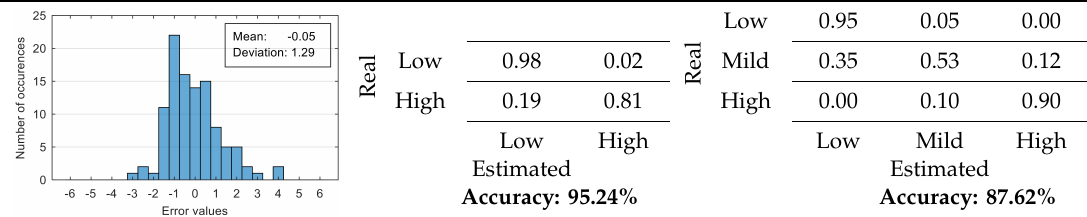
Table 10. Distribution of estimation errors and confusion matrices for levels 2 and 3 — using five features.